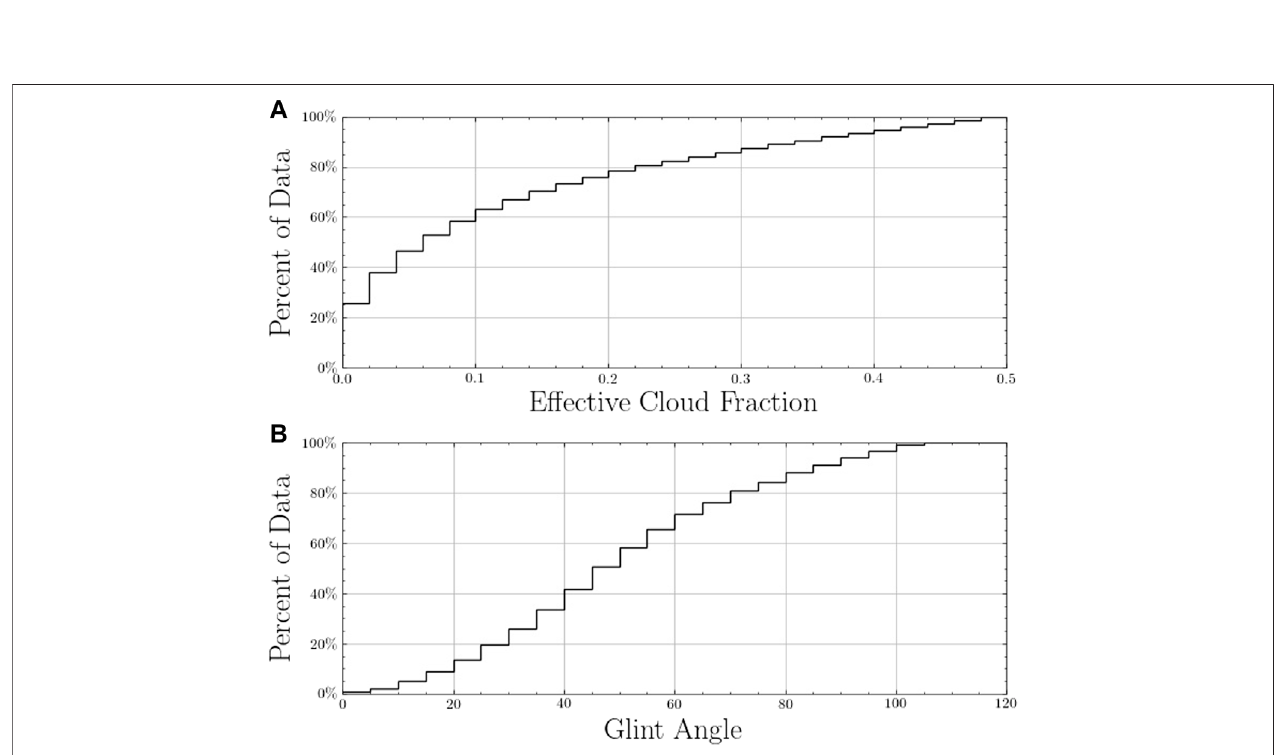
FIGURE 5 | Cumulative histograms of the conditions that are included in the input data to the TROPOMI NN training. (A) shows the ECF for the input data and (B) shows the glint angle of the NN training inputs.